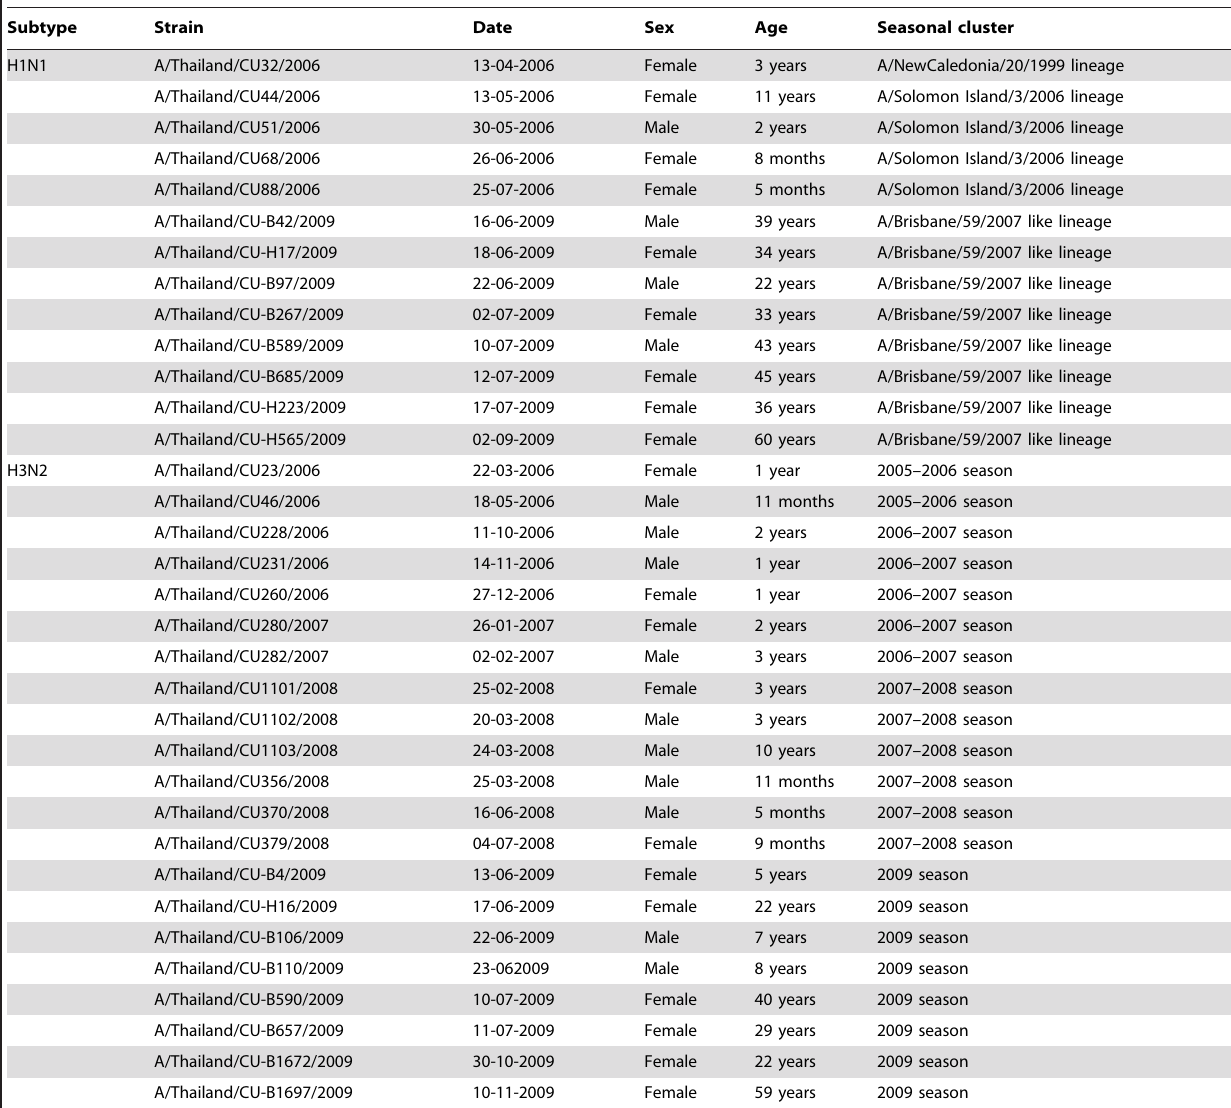
Table 1. The details of the